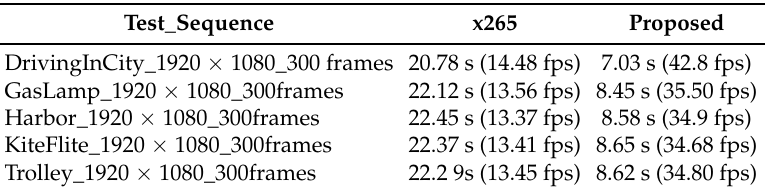
Table 5. The 360 transcoding